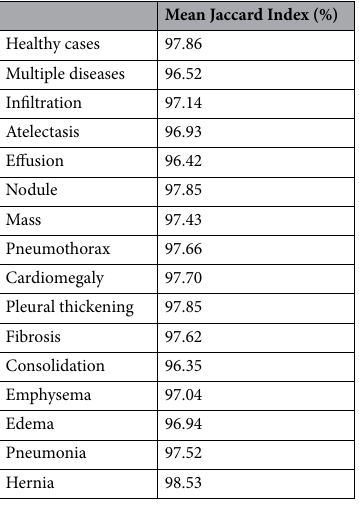
Table 5. CXR images with different cases have different segmentation scores. Multiple diseases mean a CXR image with two or more diseases.